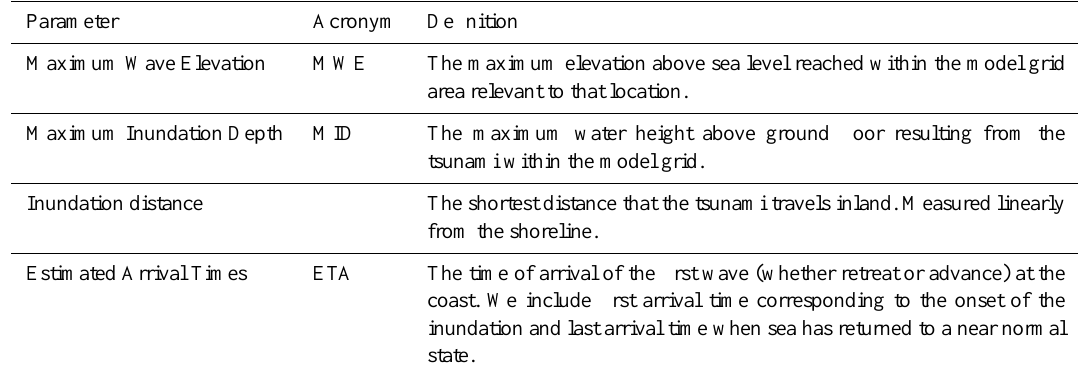
Table 3. Characterising parameters of tsunami generated by the numerical modelling.